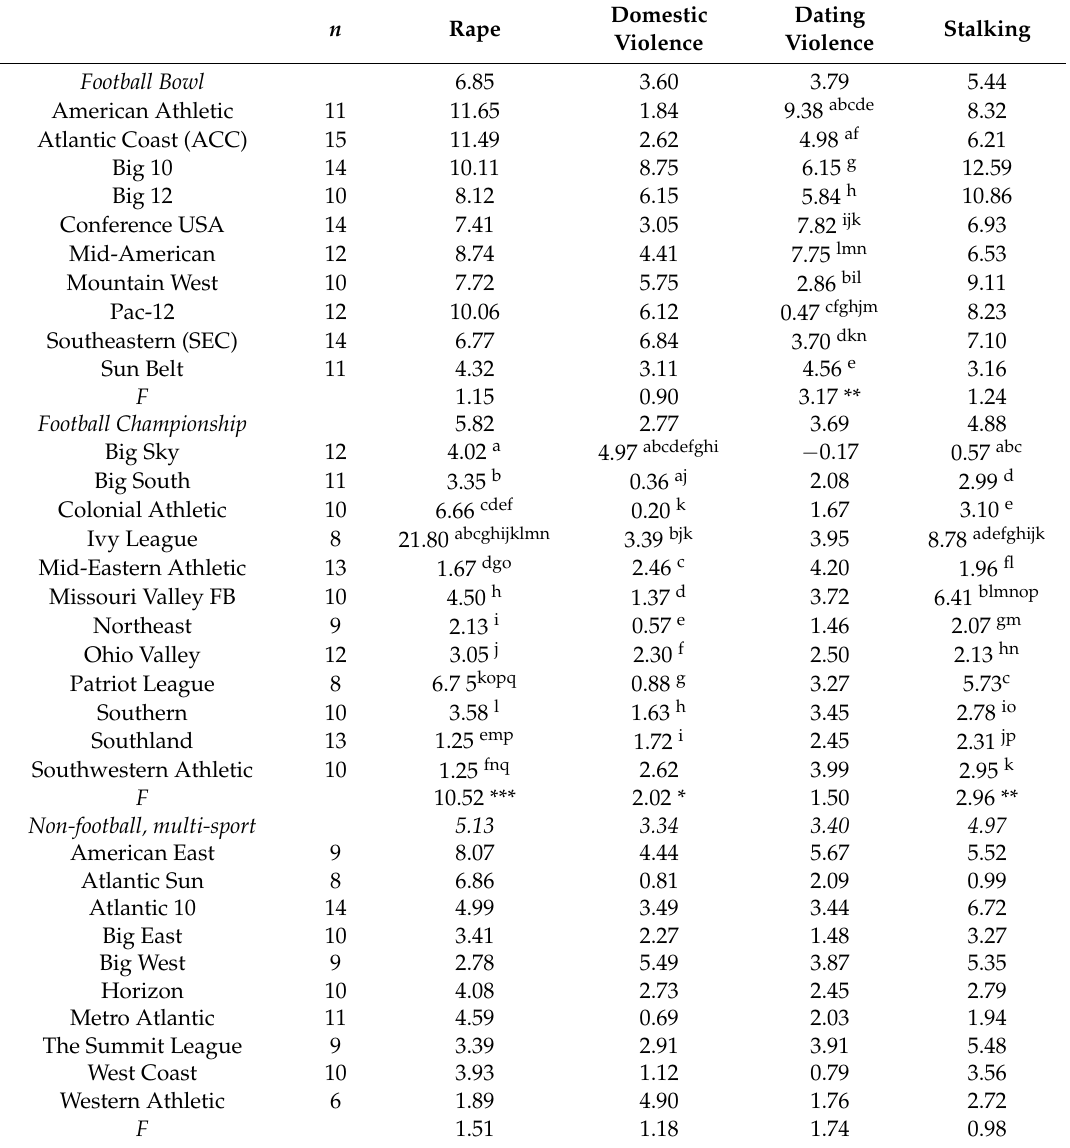
Table 2. Relationship violence within NCAA division I